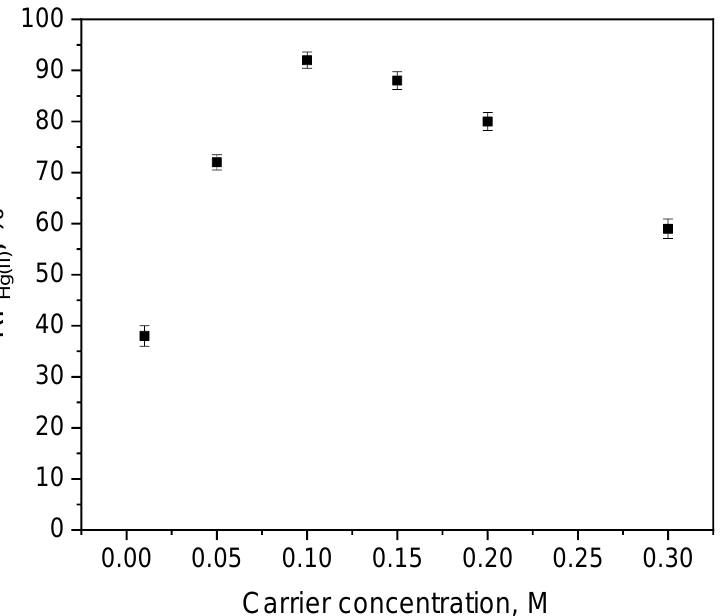
Figure 3. A suggested mercury–calix[4]pyrrole (KP) complex transport mechanism through PIM membrane (X − = Cl − ).